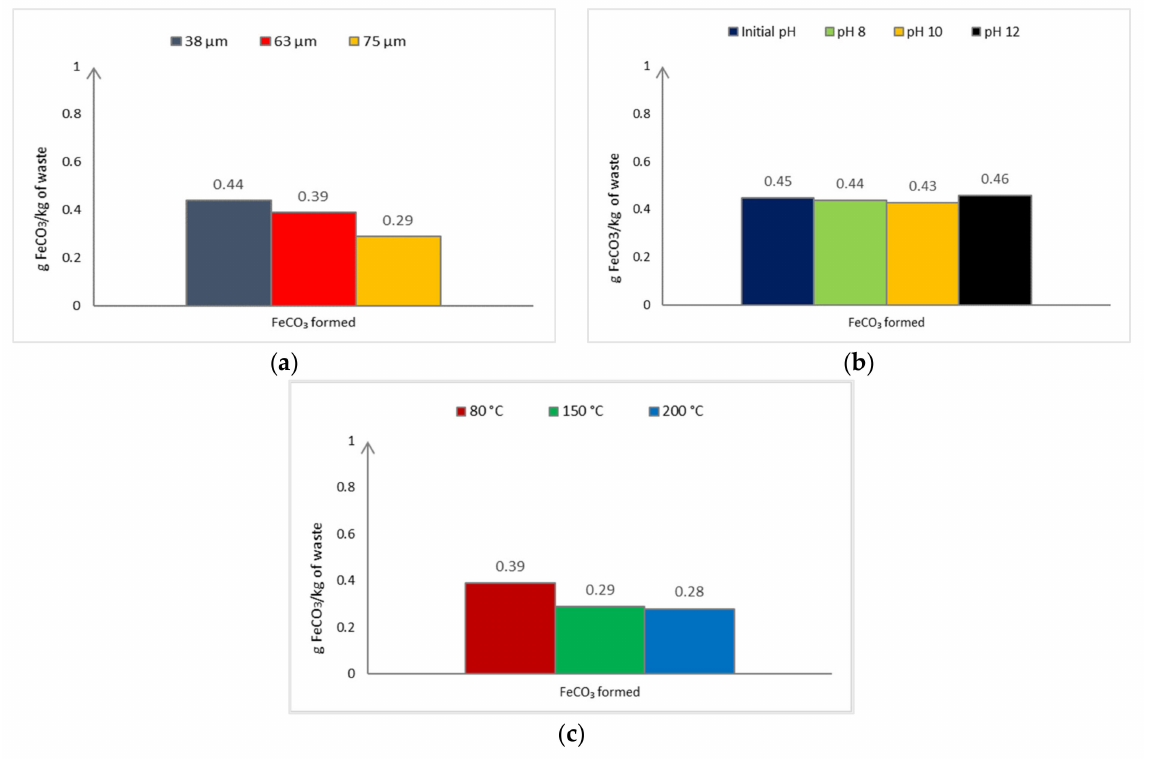
Figure 11. Carbonate product formed (g/kg of waste) of Fe-rich waste in different ( a ) particle size, ( b ) pH condition and ( c ) reaction temperature.